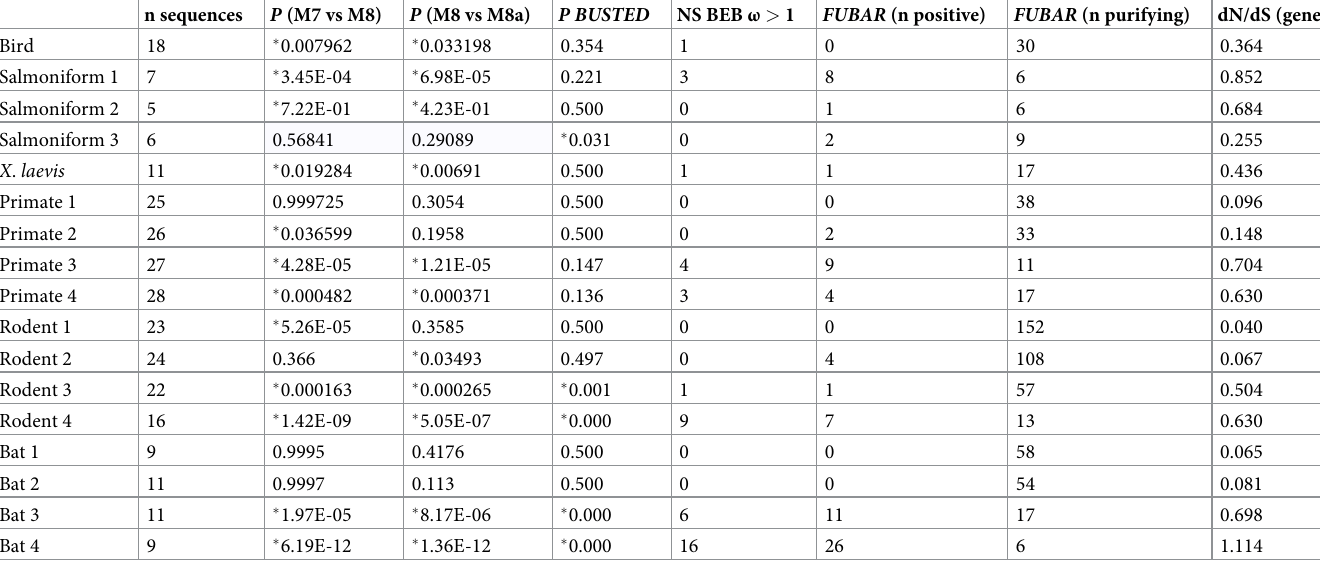
Table 1. Evolutionary analysis of select vertebrate RTP